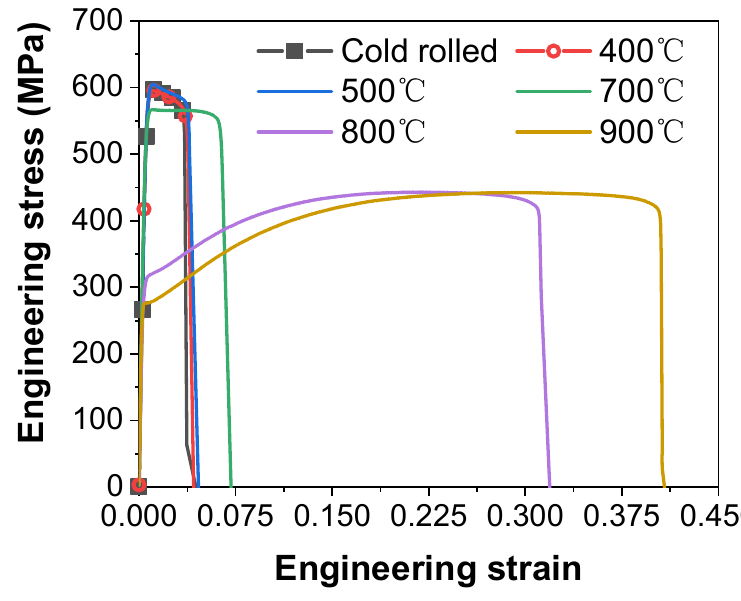
Figure 5. Stress strain curves of the specimens.